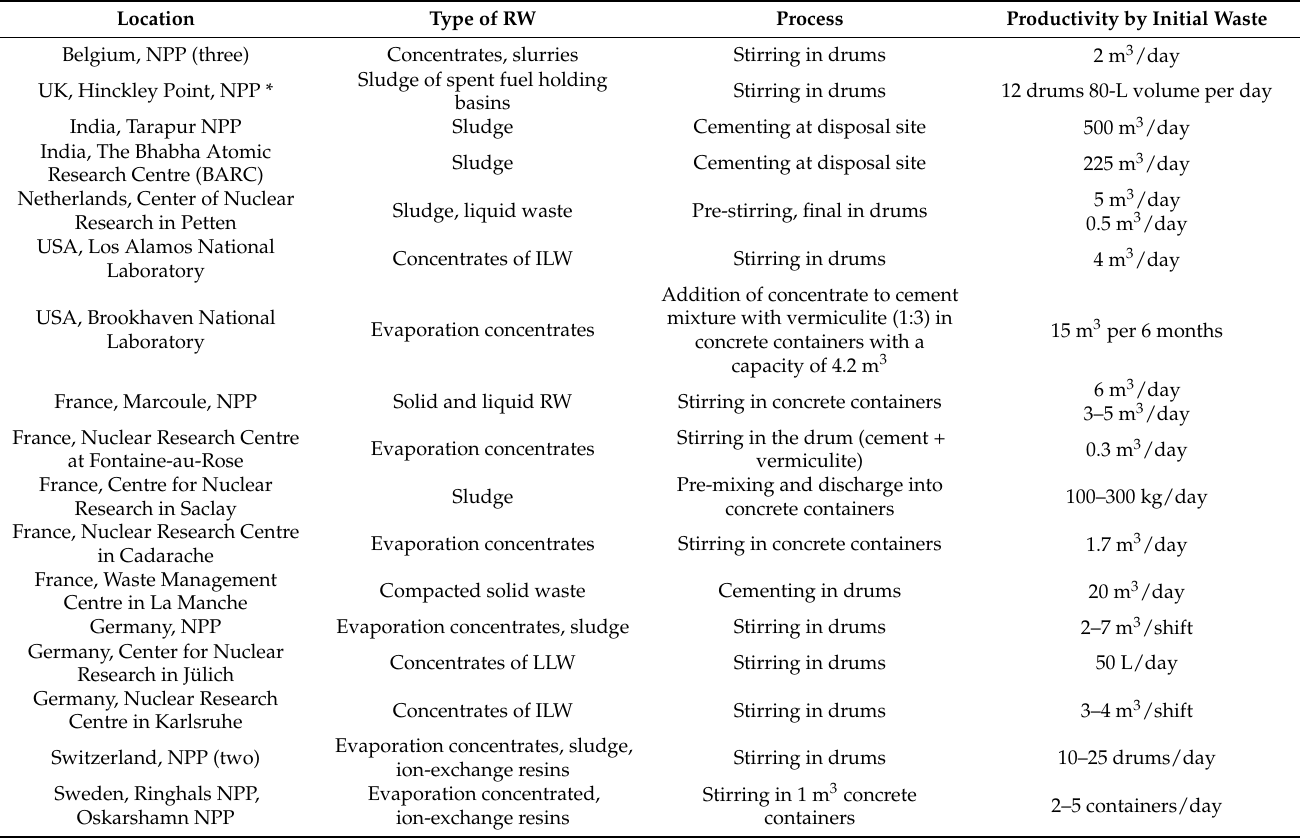
Table 1. International experience in RW cementing